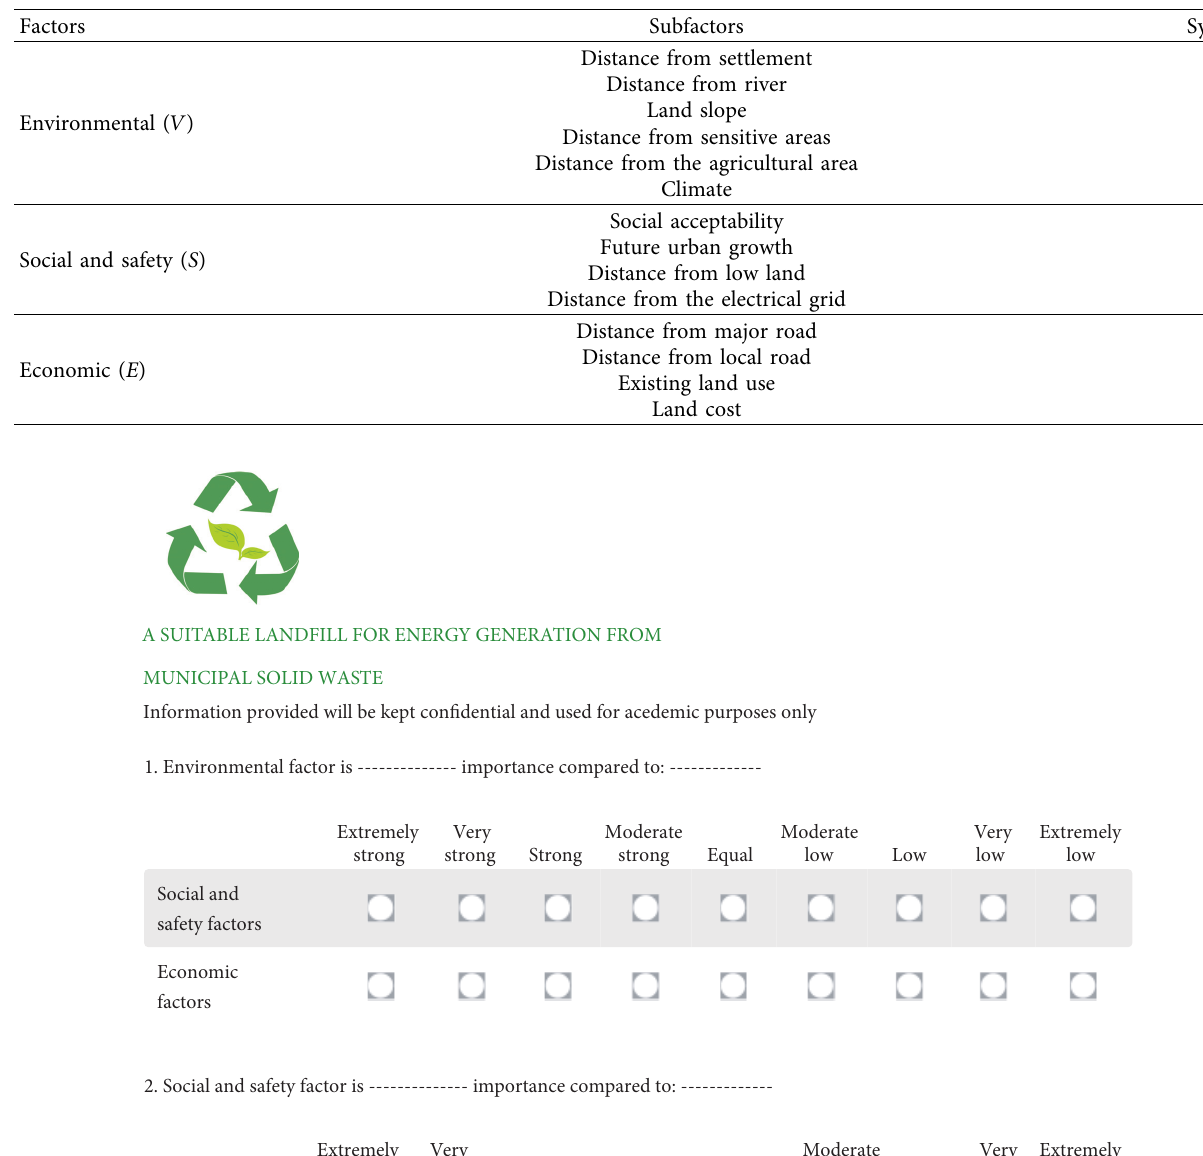
Table 1: The factors and subfactors symbol.